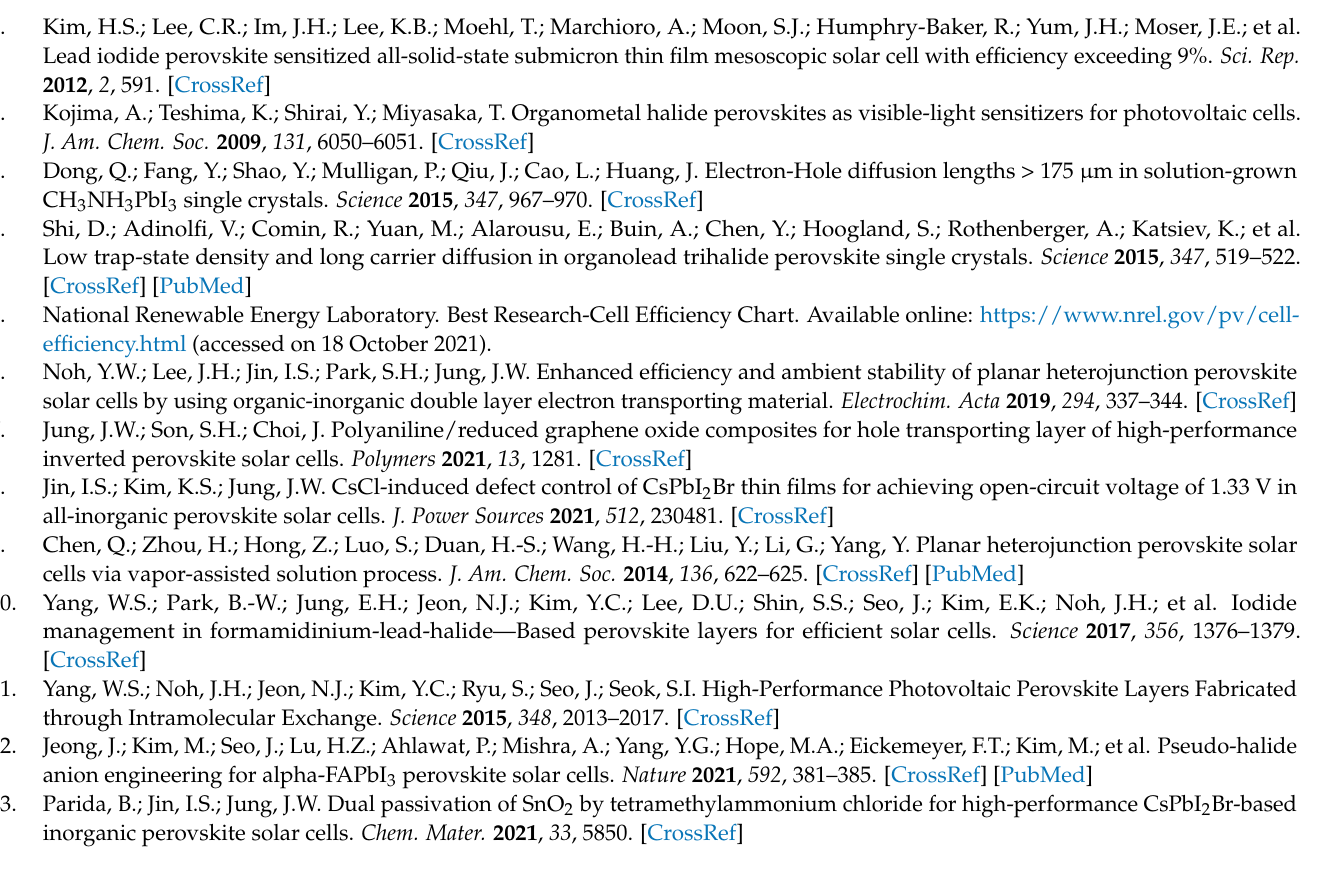
Figure S3: Theoretical XRD for ZrSnO 4 film, Figure S4: Conductivity measurement, Figure S5: J − V curve of device, Figure S6: J − V curves of device after light soaking, Table S1: TRPL parameter, Table S2: photovoltaic parameters, Table S3: photovoltaic